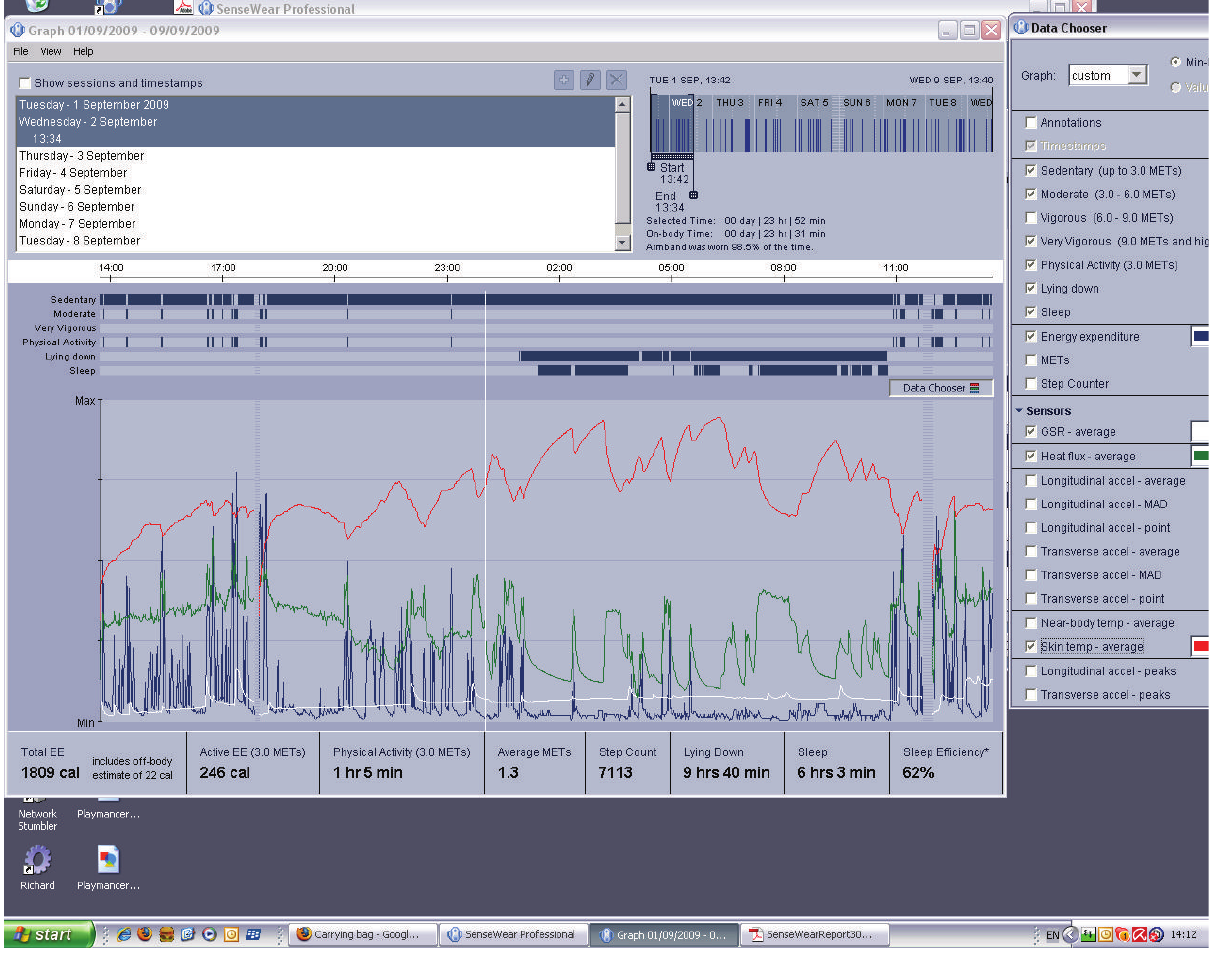
Figure 5: Pattern over one day (note activity levels around 17.00 at the time the subject log reports a stressful drive in rush hour tra ffi